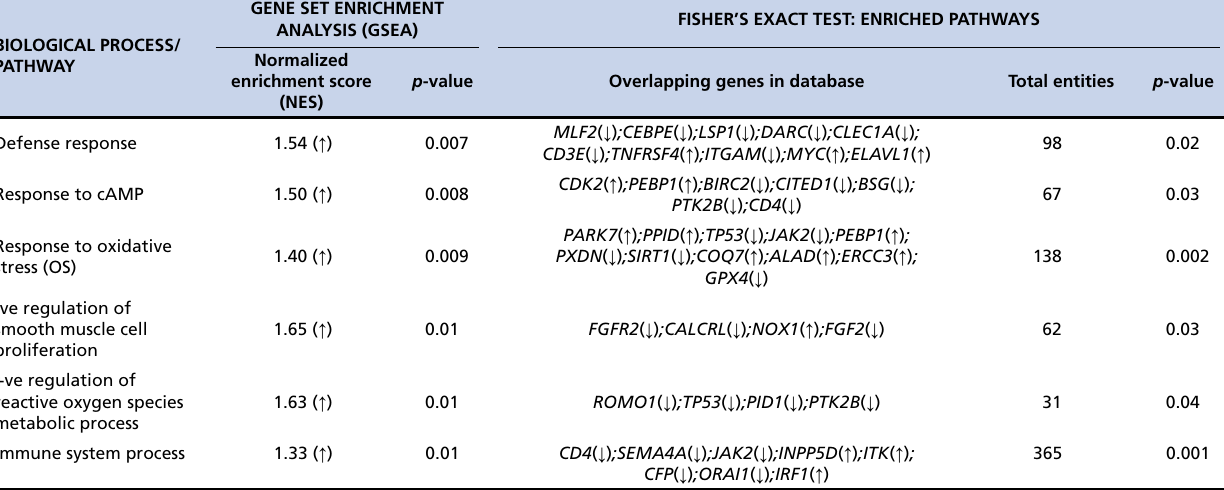
Supplementary Table 1 - List of biological processes and genes significantly modulated in male subjects after 3 months of α